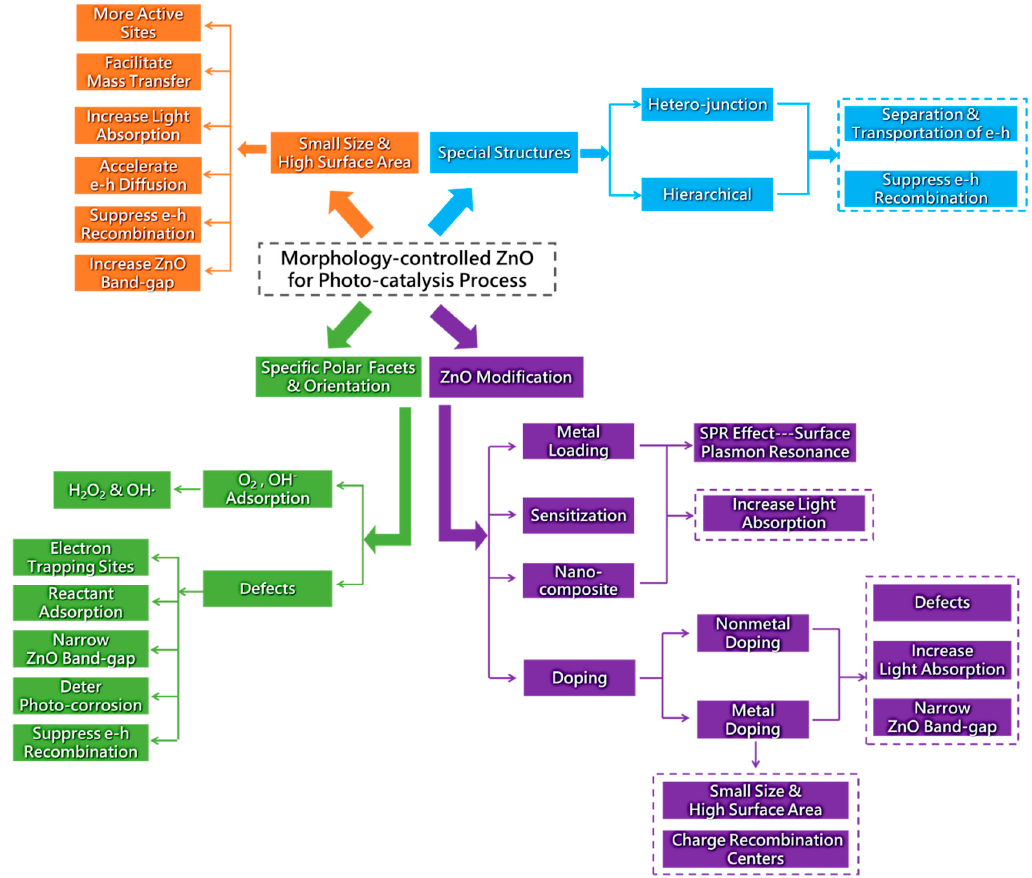
Figure 14. Promotion mechanism illustration of morphology controlled ZnO in photo ‐ catalysis.